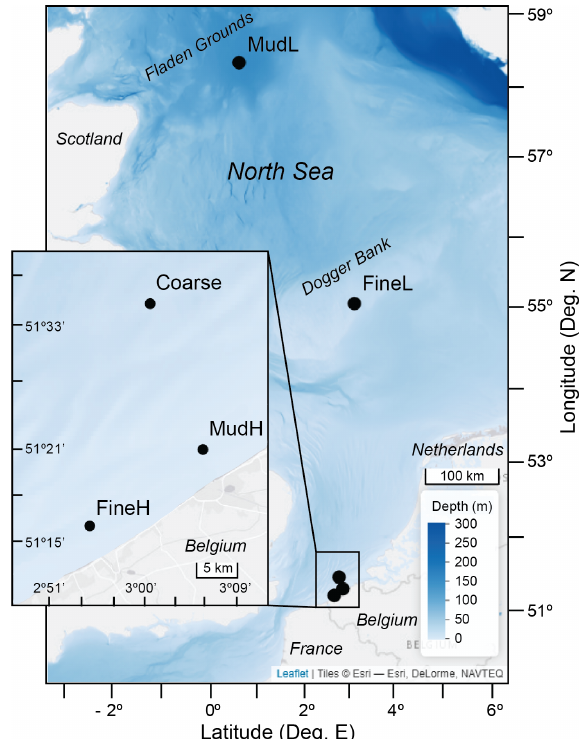
Figure 1. Sampling locations in the North Sea. Offshore stations MudL and FineL sampled by De Borger et al. (2021), and nearshore stations (inset) in the Belgian part of the North Sea sampled by Tou- ssaint et al. (2021). Low (L) nutrient content relative to high (H) nutrient content. Basemap: © Esri, depth raster by GEBCO Compi- lation Group